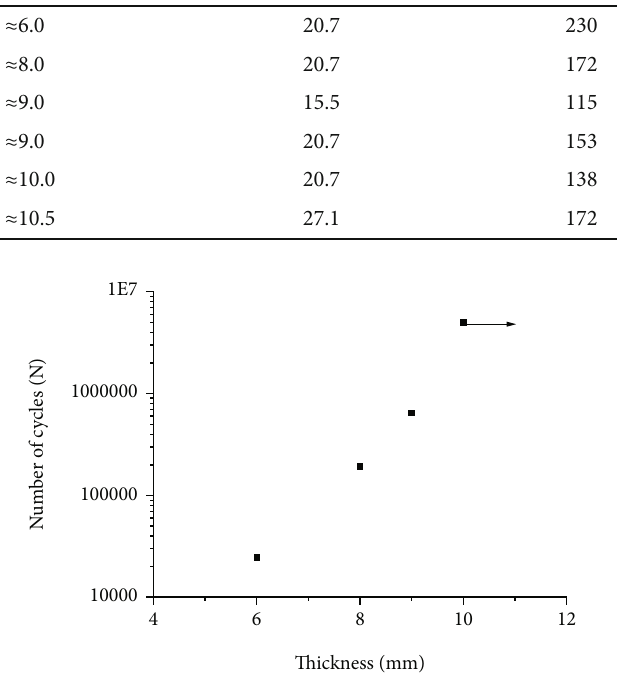
Figure 15: The variation of fatigue life with thickness under the nominal stress amplitude is 115